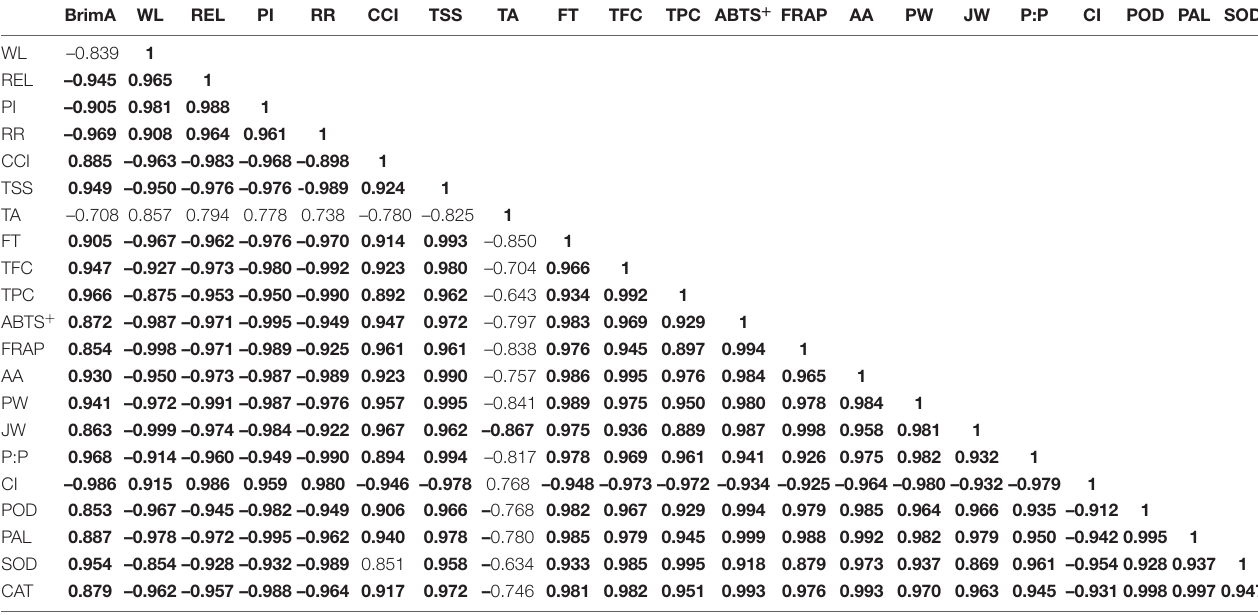
TABLE 3 | Pearson’s correlation coefficients ( r ) matrix between quality attributes of uncoated and coated ‘Kinnow’ mandarin fruit stored for 40 days at 5 ± 1 ◦ C. BrimA